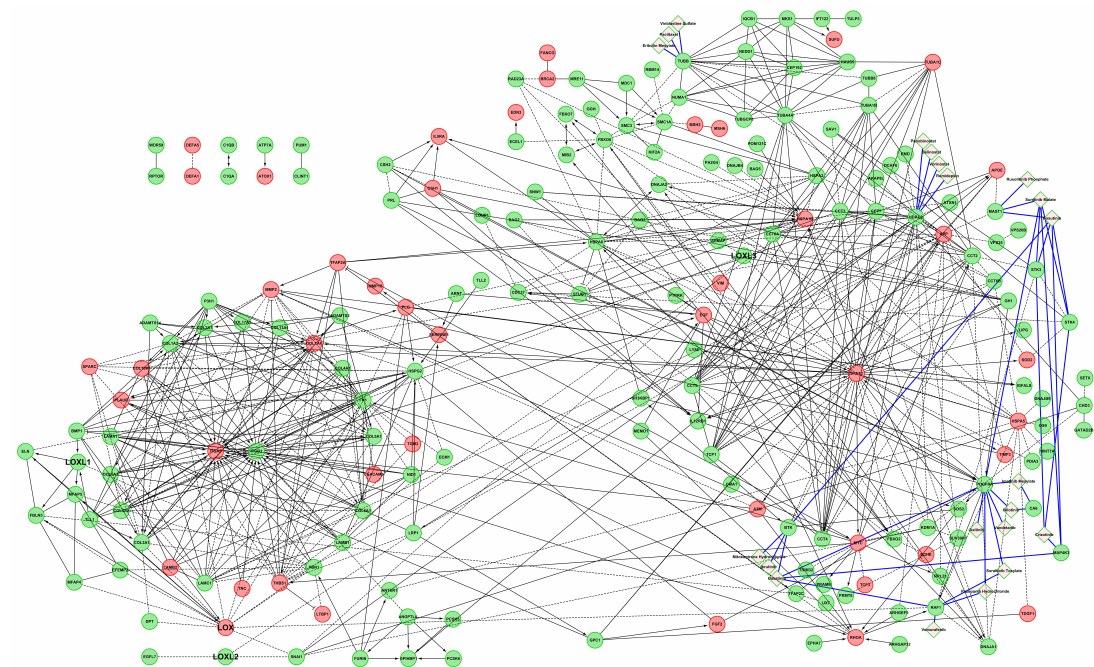
Figure 9. Drug–target interactions identified in the functional interaction network generated using Reactome FIViz. Green: proteins, Red: proteins annotated with cancer-related condition, Diamonds: drugs. Blue edges: interactions between drugs and targets, arrowheads: activating and catalyzing or expression regulation, dotted lines: predicted functional interactions, ⊥ for inhibition, solid line for complexes or